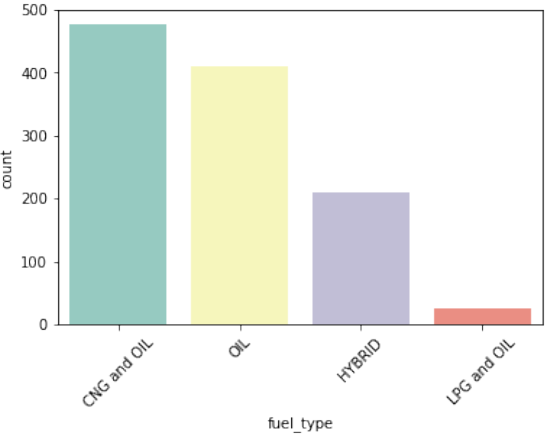
Figure 4. Number of cars with different fuel_type